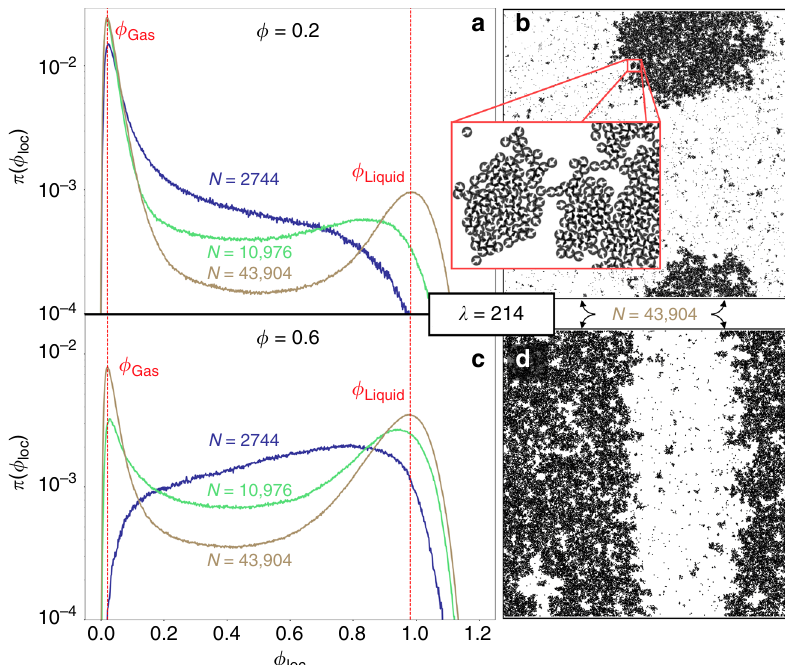
Fig. 4 Finite-size scaling of local density histograms. Data with λ = 214 and δ = 0.7. a , c Local density histograms (see Methods for de fi nitions) for global densities ϕ = 0.2 and ϕ = 0.6 (identical x axis used). Local density peaks sharpen with increasing system size N , and are located at the same value of ϕ loc , demonstrating that in the MIPS region gas and liquid densities are independent of the global density. b , d Snapshots of con fi gurations at global densities corresponding to a , where the liquid is the minority phase, and c , where the liquid is the majority phase by volume fraction (cf. height of the peaks in a and c ). Inset in b Direction of motion of the individual particles indicated by arrows, illustrating the origin of MIPS. The directions of motion are uncorrelated inside the homogeneous liquid and gas. Only particles at the interface move towards the interior of the liquid patch, enclosing particles of the high-density